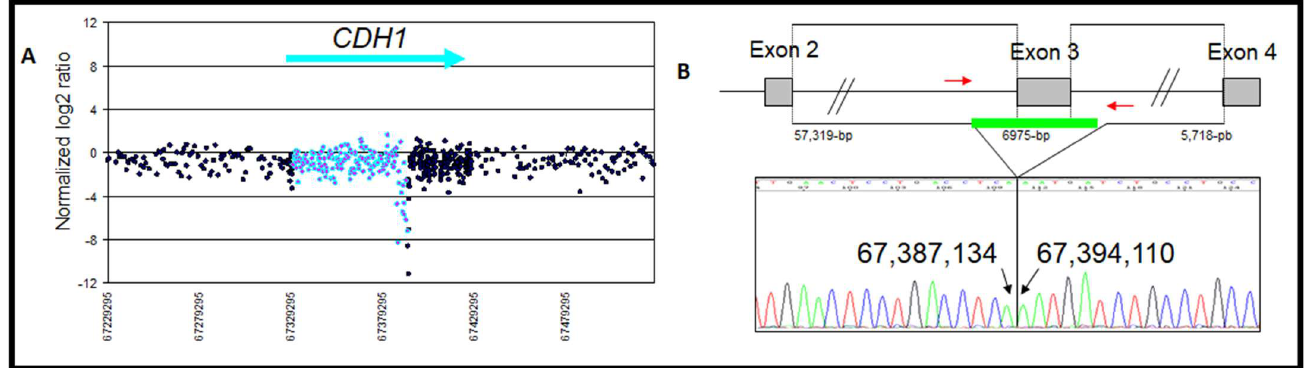
Figure 2. ( A ) Array CGH profile obtained for the heterozygous exon 3 deletion of the CDH1 gene. Intron 2 is represented in blue dots. ( B ) Sequencing chromatogram of the mapped breakpoint for the exon 3 deletion from chr16: 67,387,135 to 67,394,109. Gray box: exons; green line: deletion locus. Red arrows: position of sequencing primers.